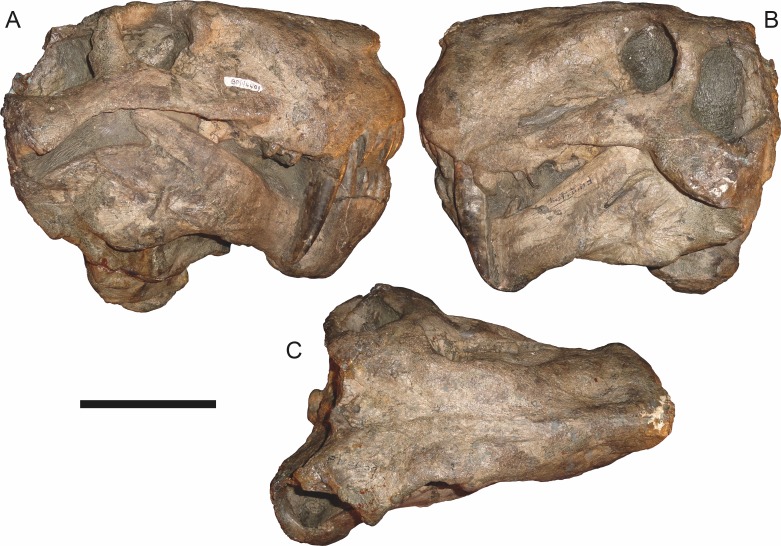
Referred specimen (BP/1/4409) of Smilesaurus ferox
Broom, 1948 in (A) right lateral, (B) left lateral, and (C) dorsal view.Scale bar equals 10 cm.